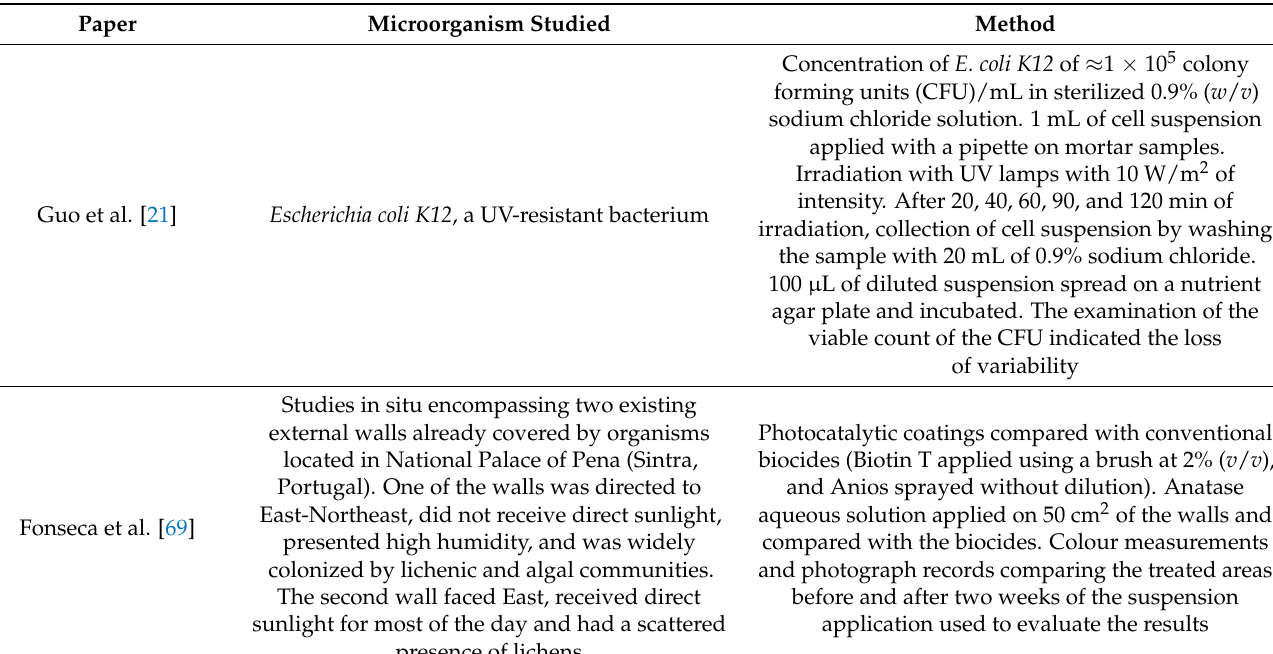
Table 6. Details on the microorganisms and methods used to investigate the antimicrobial properties provided by thin TiO 2 -based coatings in the studied